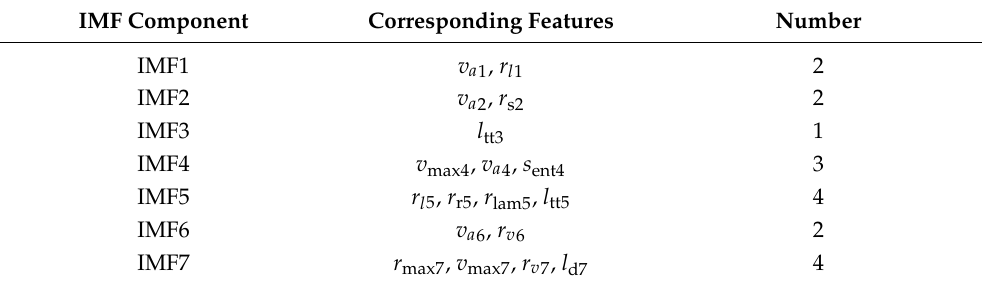
Table 4. Feature selection